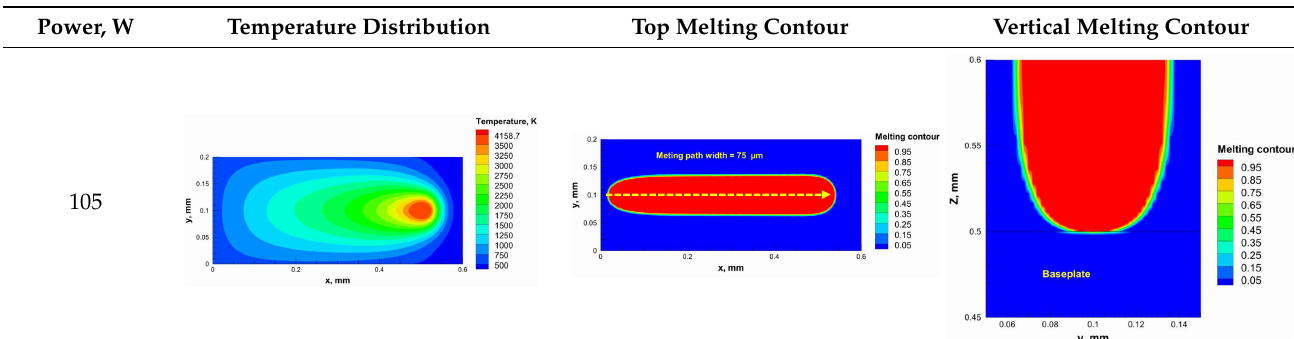
Table 5. Temperature distribution and melting contour obtained from the numerical model (Nd-YAG).